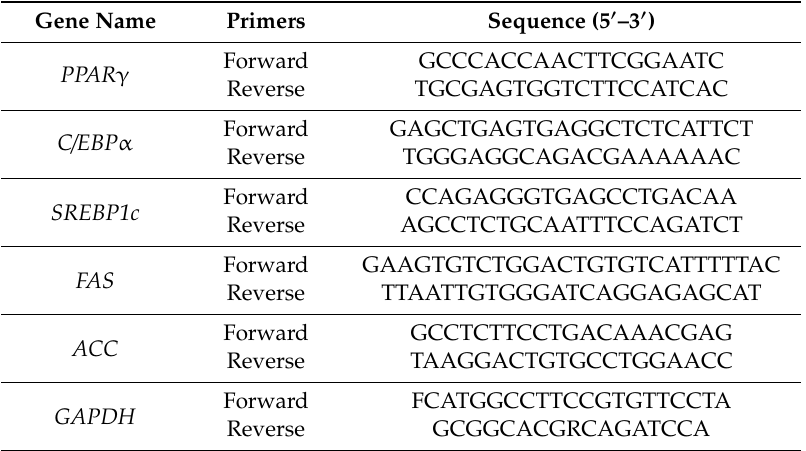
Table 1. List of primers used for